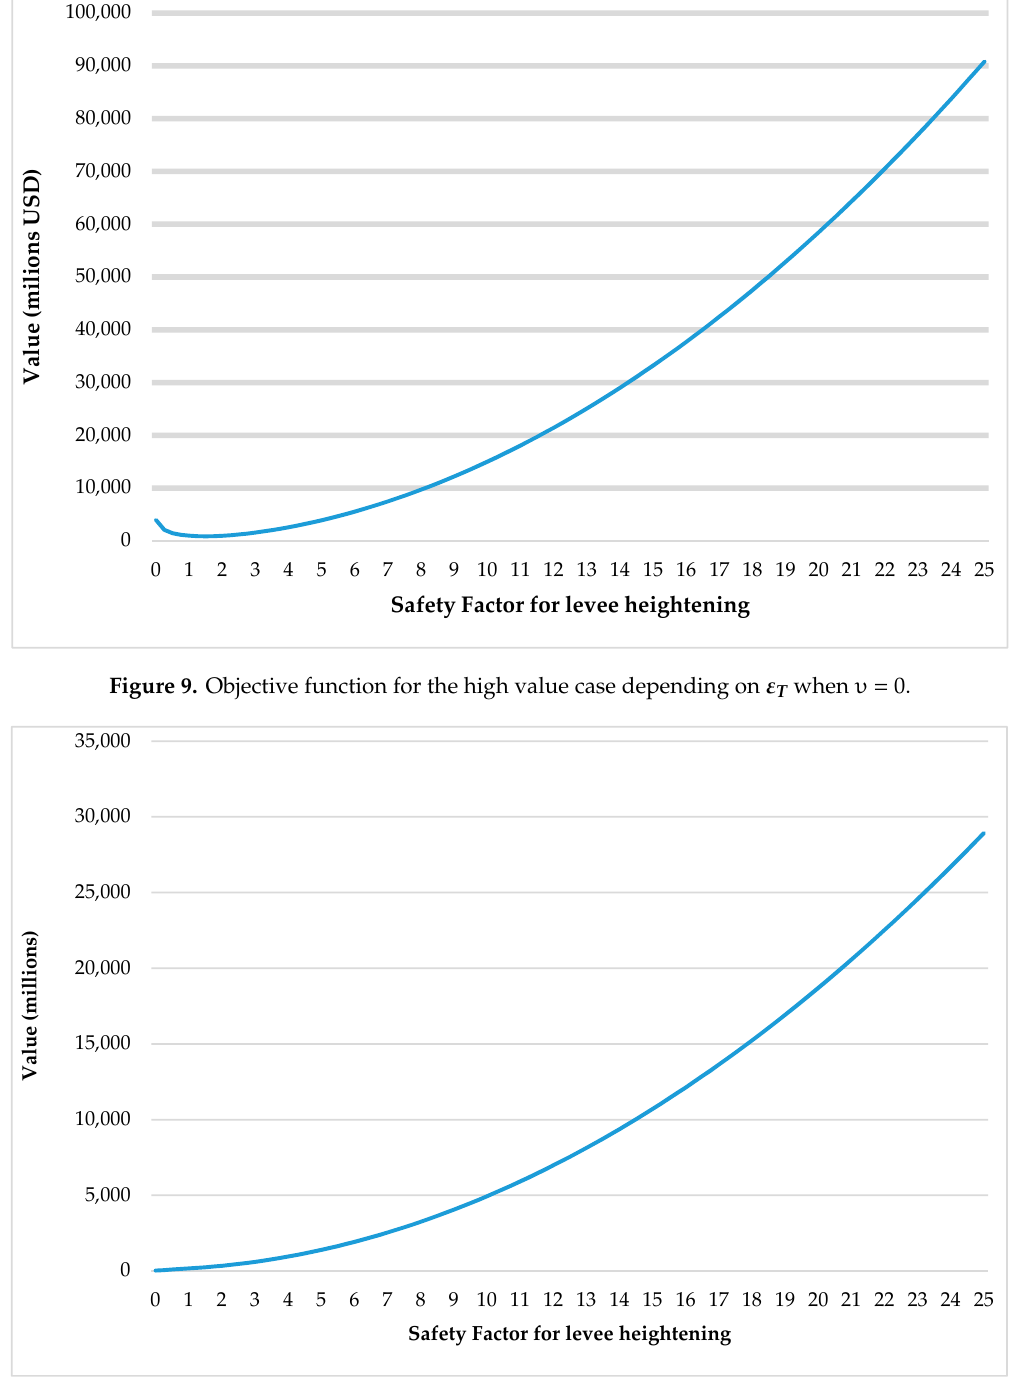
Figure 10. Objective function for the low value case depending on 𝜺 𝑻 when υ = 0. Table 7. Optimal safety factor for levee heightening for Technosociety.